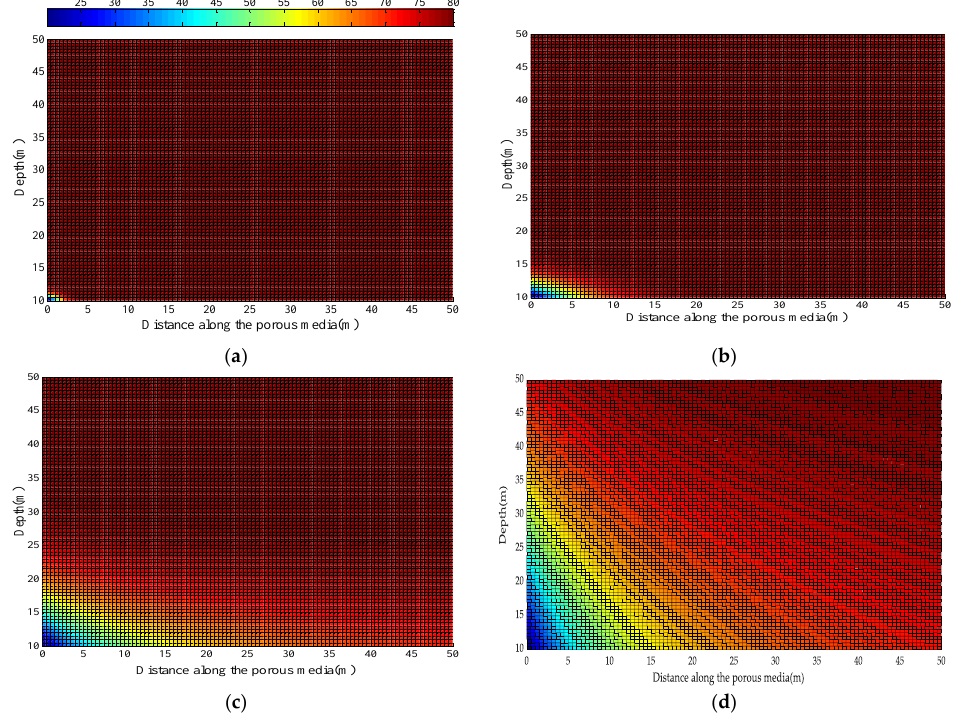
= 1.2 W/m·K at ( a ) 10 days, ( b ) 100 1